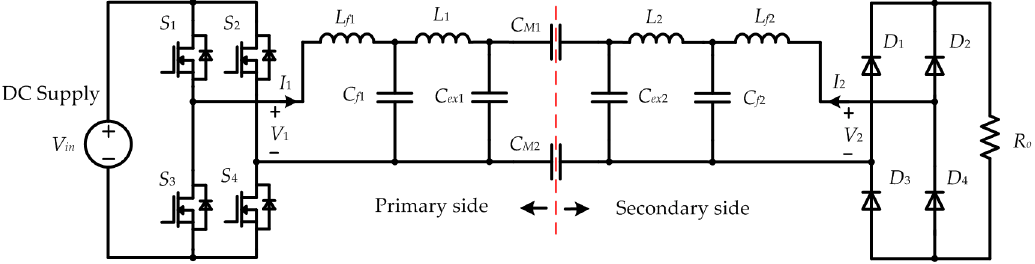
Figure 18. Circuit topology of a CPT system based on full-bridge inverter with double-sided LCLC compensation.